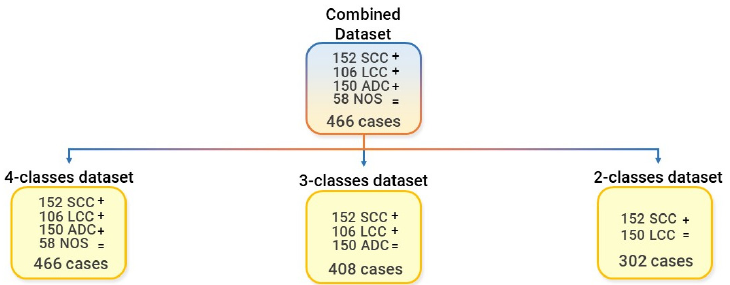
Figure 3. Final dataset subdivision into the 4-classes dataset, 3-classes dataset, and the 2-classes dataset.